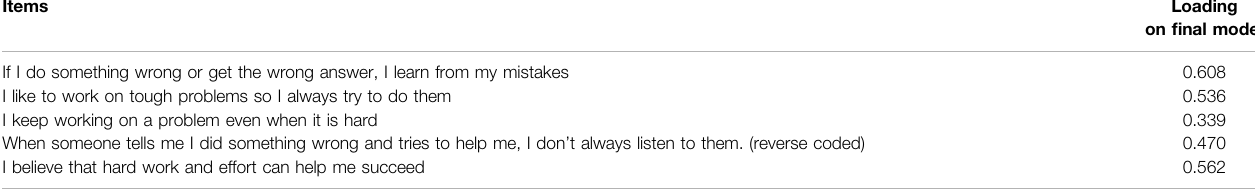
TABLE 1 | Factor loading for Children ’ s persistence. Items